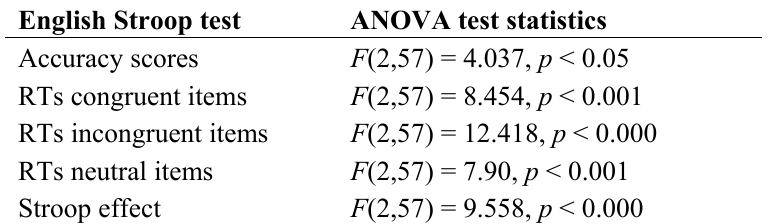
Table 5. ANOVA test statistics in relation to the English Stroop test with age as factor.